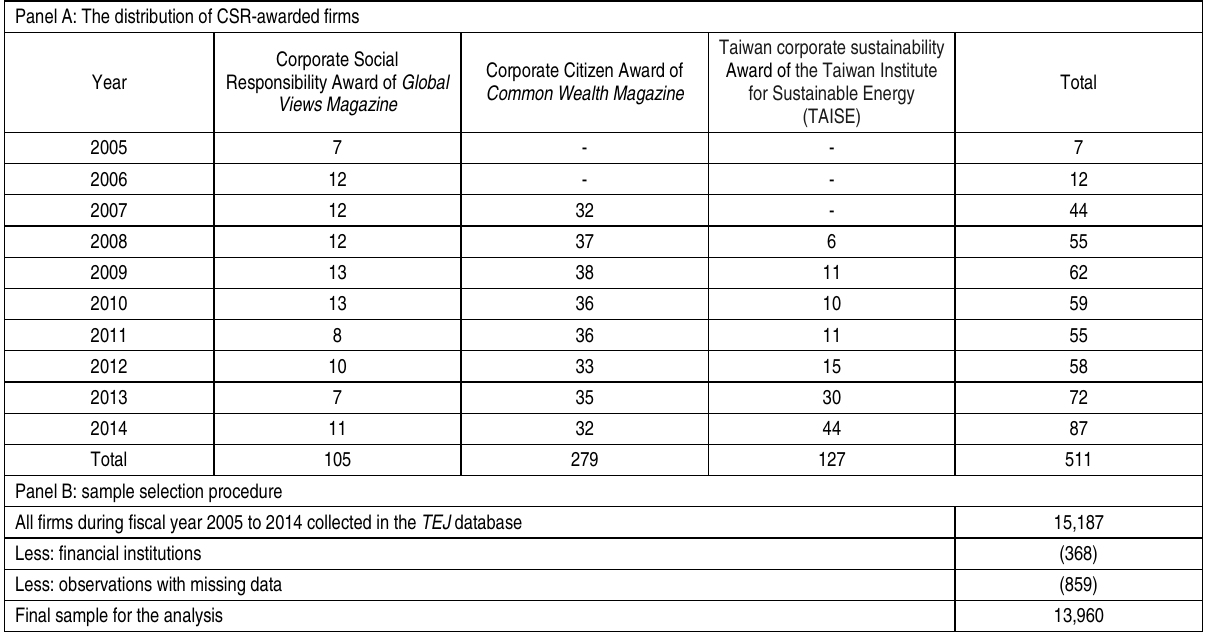
Panel B: sample selection procedure